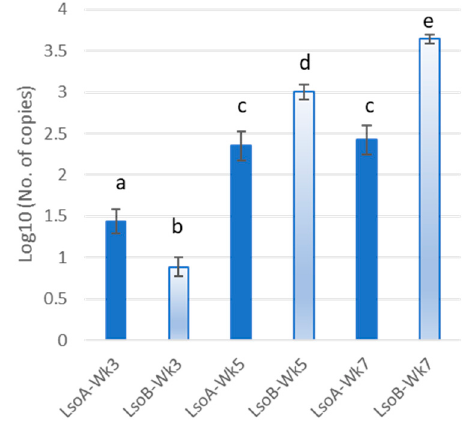
Figure 2. Lso quantification. Quantification of Lso copies in tobacco leaves at 3, 5, and 7 weeks following B. cockerelli infesta- tion. The values reported are log10 of Lso copy number, normalized by the standard curve method. Dark bars represent LsoA titer and lighter bars represent LsoB titer. Data represent means ± standard error of the mean. Different letters indicate statistical differences at p -value < 0.05 using Kruskal-Wallis rank sum test, followed by pairwise comparisons using the Wilcoxon rank sum exact test with p -values adjusted with the Benjamini-Hochberg method.